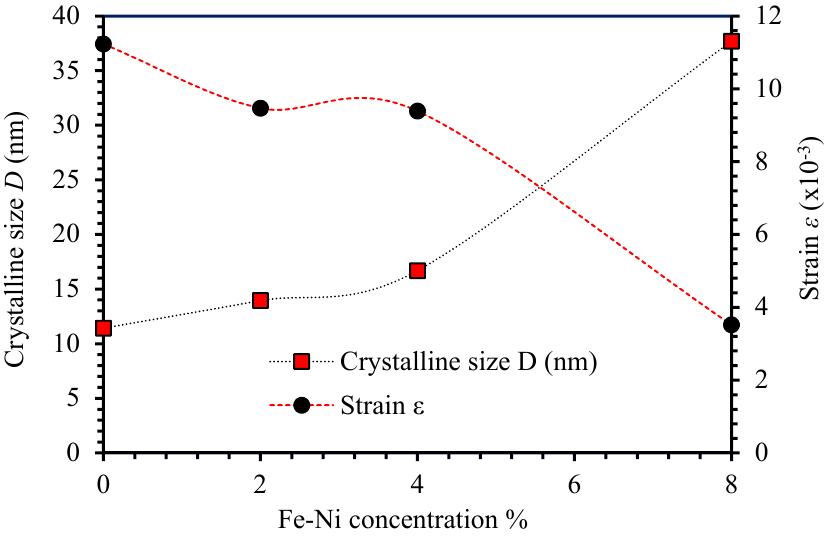
Figure 3. The crystallite size, D and the microstrain (cid:104) ε (cid:105) of undoped ZnO and Fe-Ni co-doped ZnO thin Figure 3. The crystallite size, 𝐷 and the microstrain 〈𝜀〉 of undoped ZnO and Fe-Ni co-doped ZnO films as a function of their thin films as a function of their concentration.